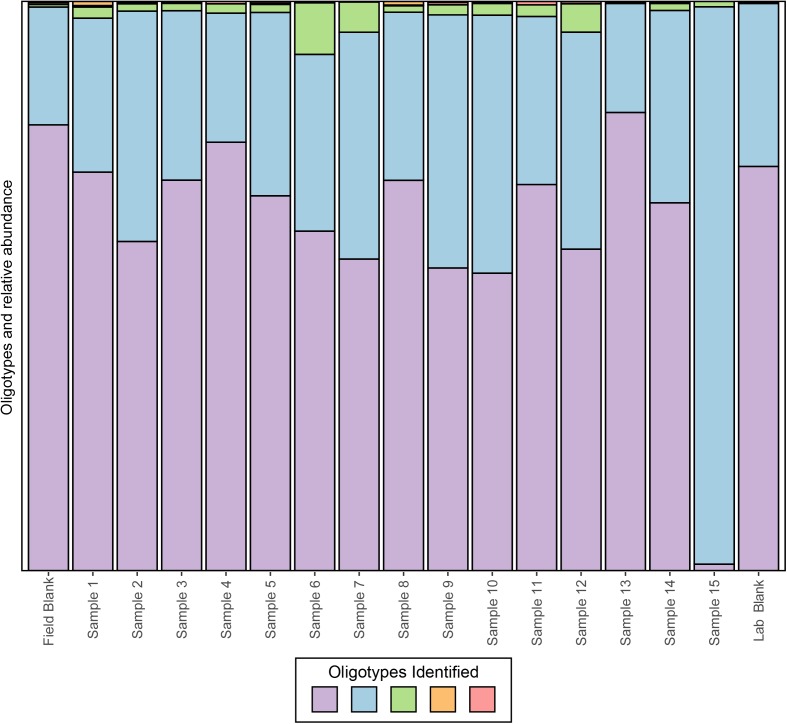
Oligotyping of sequences associated with the dominant OTU identified to genus Propionibacterium from an example CoDL study with previously recognized contamination problems. Oligotype variants are identified by color and the size of the bar represents the relative proportion in each sample.